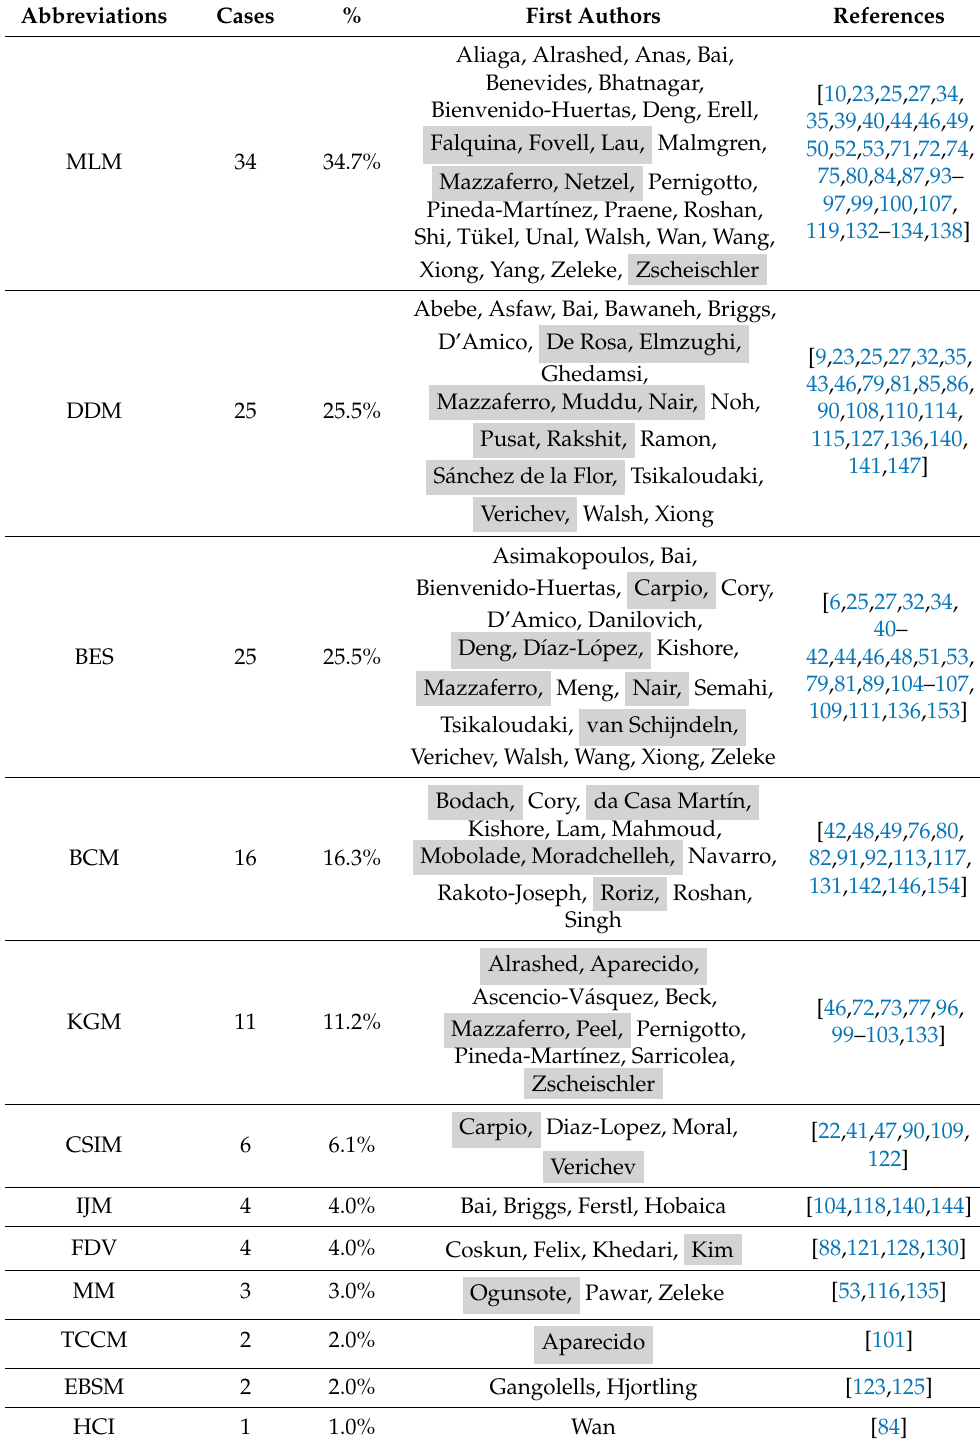
Table 4. Authors working with different CZB